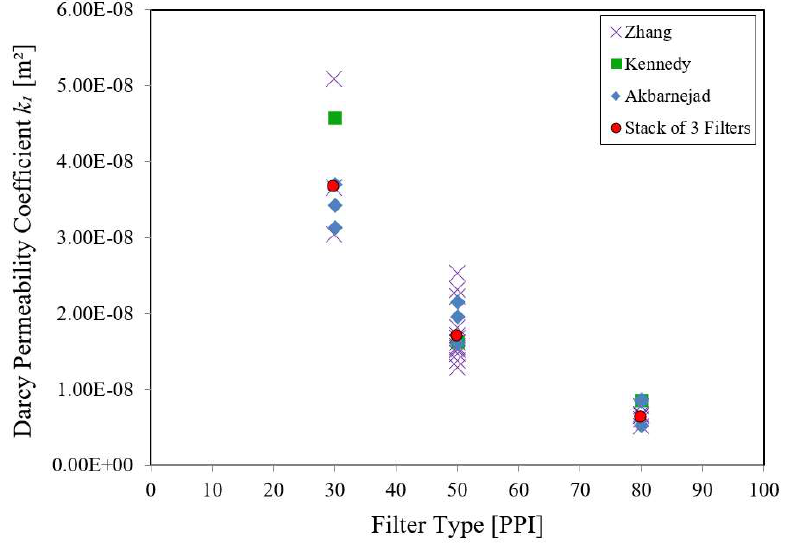
Figure 10. A comparison between the empirically obtained Darcy permeability coefficients ( k 1 ) of the recent and previous works data from [19,26,57] as a function of filter type (PPI).